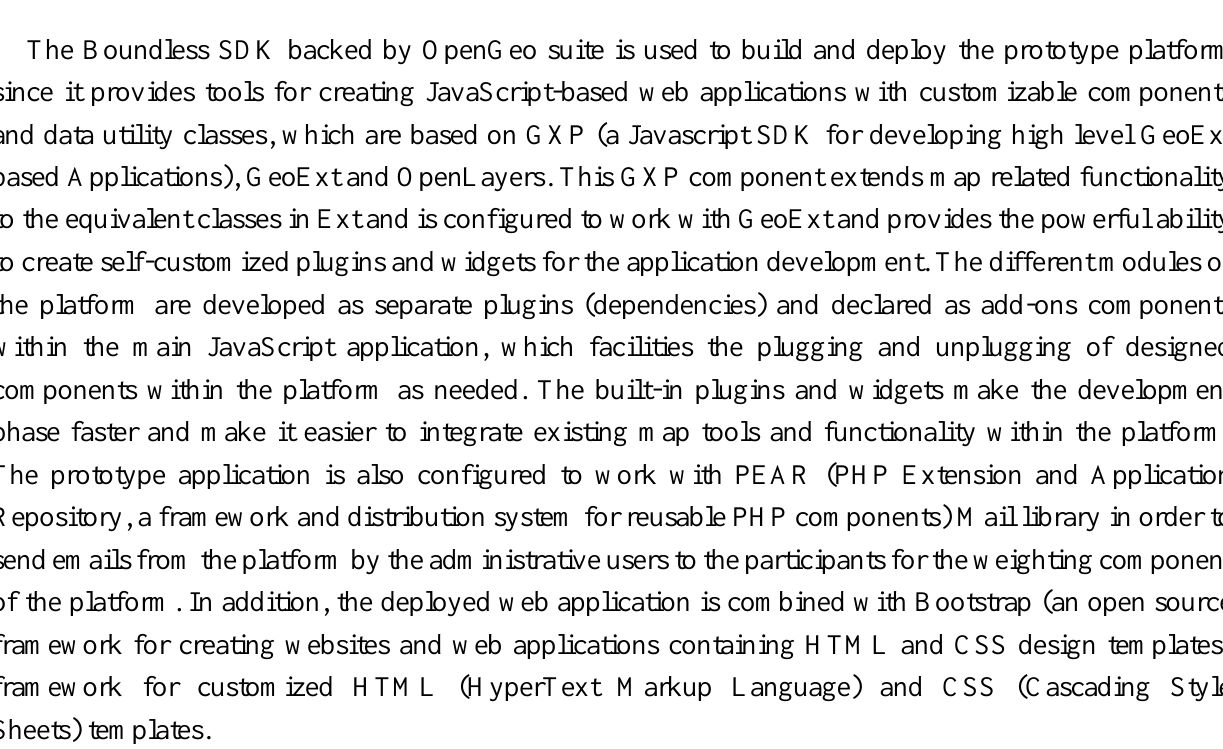
Figure 4. Open-source software stack of the